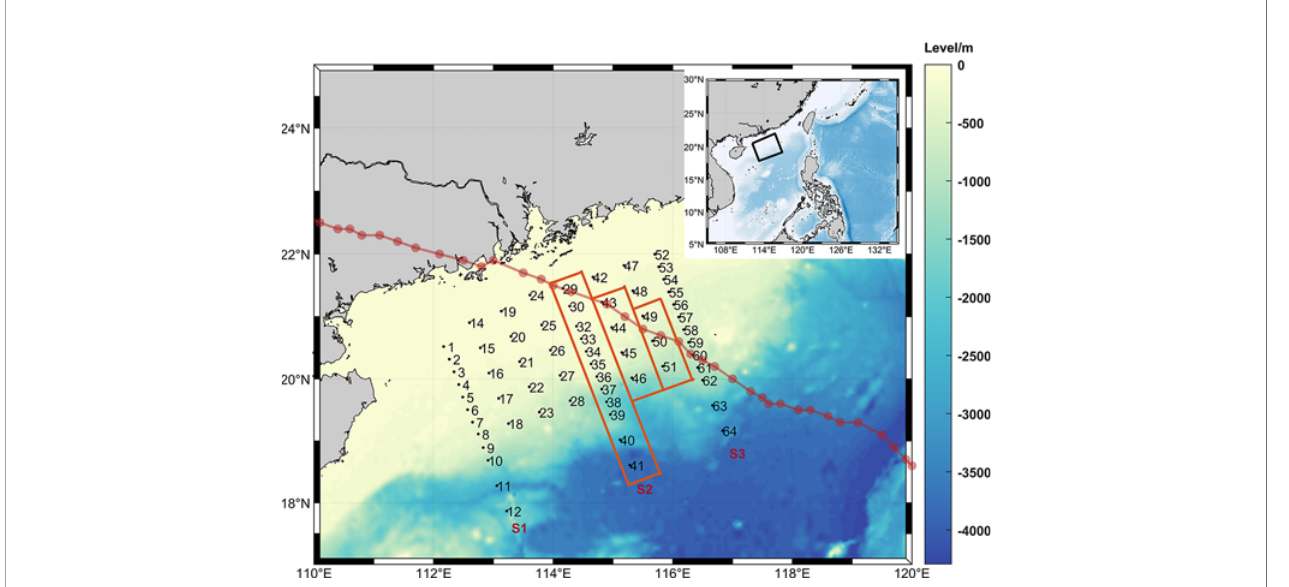
FIGURE 1 | The study area in the SCS. The black dots and numbers are the sampling stations overlaid over topography. The 3 red boxes mark stations surveyed after the typhoon. The three long sections are S1, S2, and S3 from west to east, where S2 is the section investigated after the typhoon. The dark red solid line and dots are the path of the